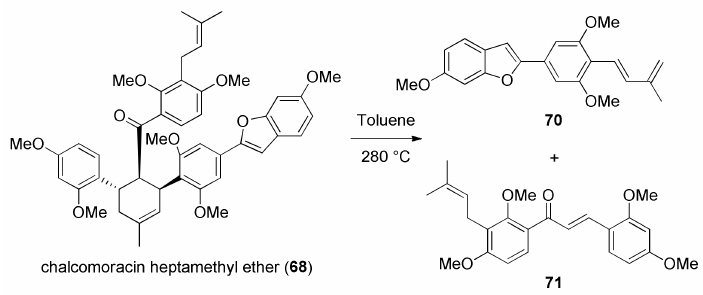
Figure 20. Retro-Diels–Alder reaction of chalcomoracin heptamethyl ether ( 68 ).